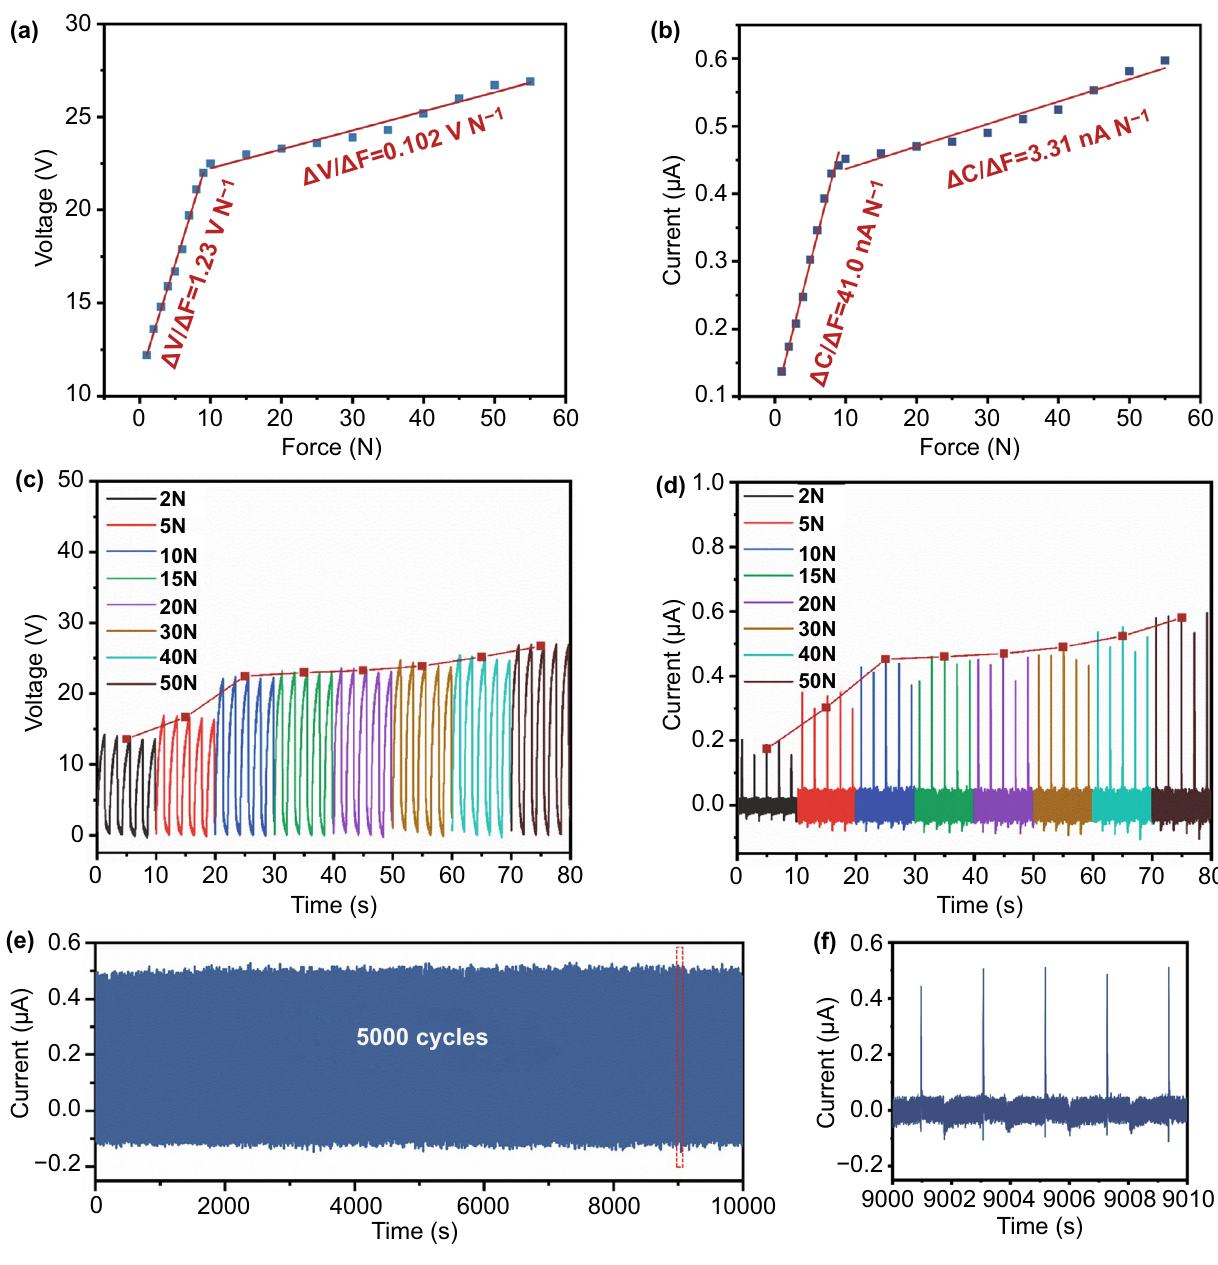
Fig. 2 Output performance and stability of BTS-GFF/PVDF sensors. a Voltage sensitivity of the BTS-GFF/PVDF sensors. b Current sensitiv- ity of the BTS-GFF/PVDF sensors. c V oc and d I sc of BTS-GFF/PVDF sensors with different applied force (2, 5, 10, 15, 20, 30, 40, and 50 N, 0.5 Hz). e, f I sc of BTS-GFF/PVDF sensors under 5000 pressing cycles (force of 40 N, 0.5